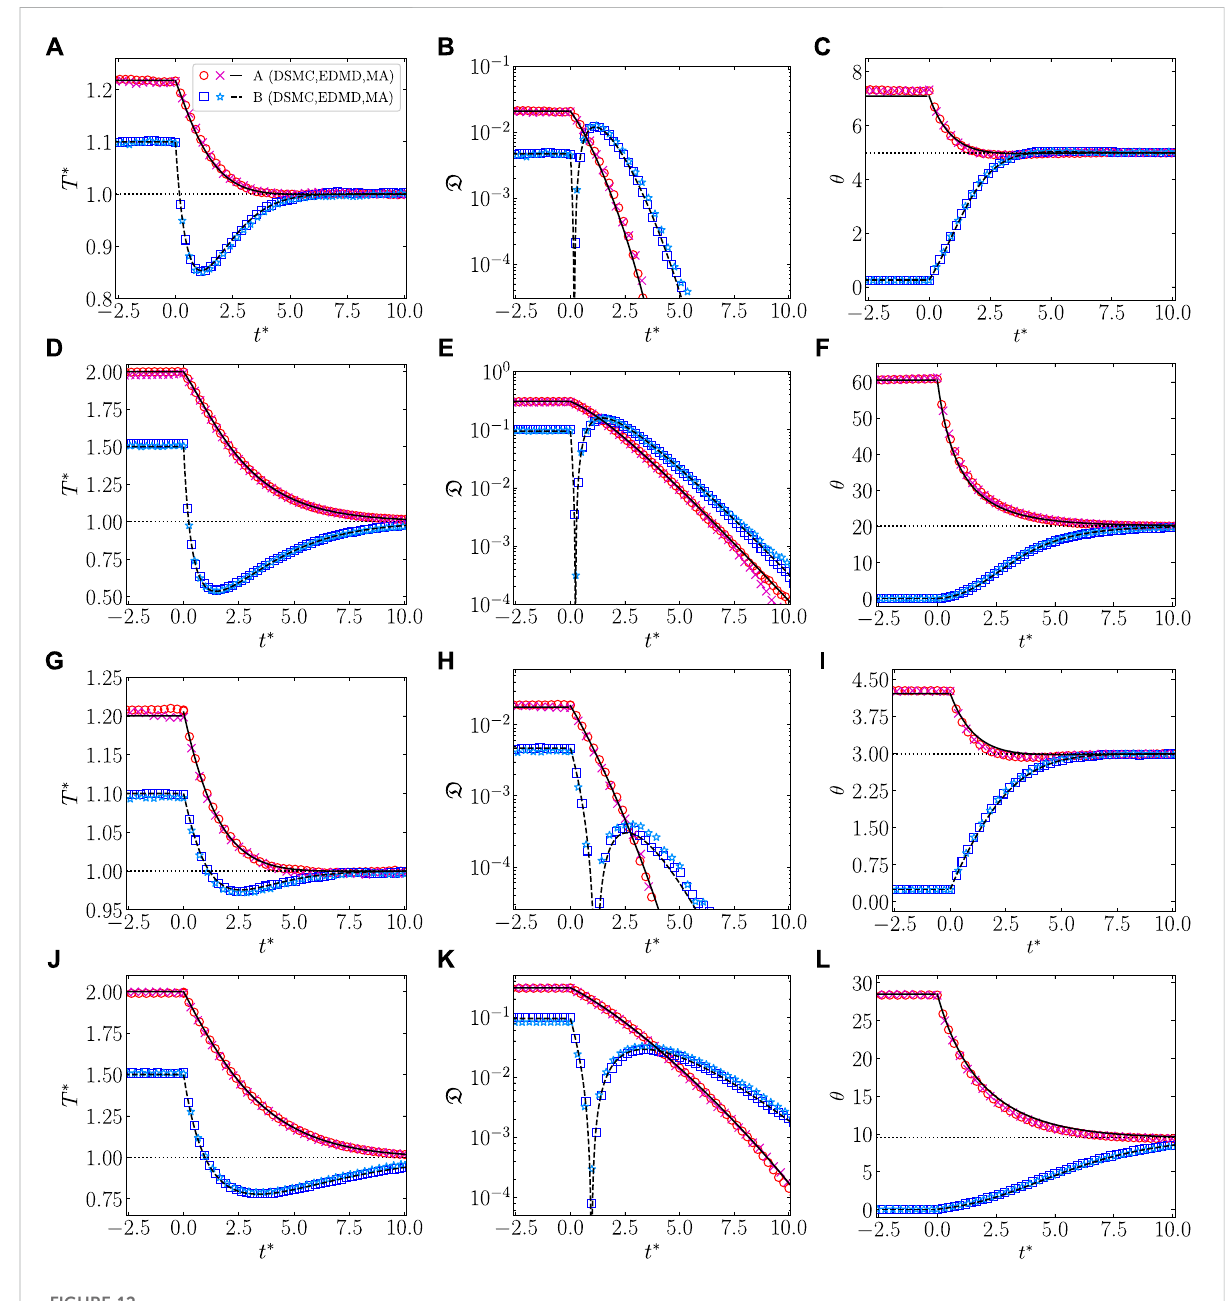
FIGURE 12 Time evolution of the reduced mean temperature T *, the entropy-like quantity D , and the rotational-to-translational temperature ratio θ for OMEinitializationprotocoldescribedinSection.3.3.2with ε ref =0.9. (A – C) :( α , β )=(0.7,0); (D – F) :( α , β )=(0.7, − 0.7); (G – I) ;( α , β )=(0.9,0); and (J – L) : ( α , β )= (0.9, − 0.7). Thickand dashed lines correspond to the theoretical prediction from Eqs.30, dotted lines represented the steady state value, and symbols refer to DSMC and EDMD simulation